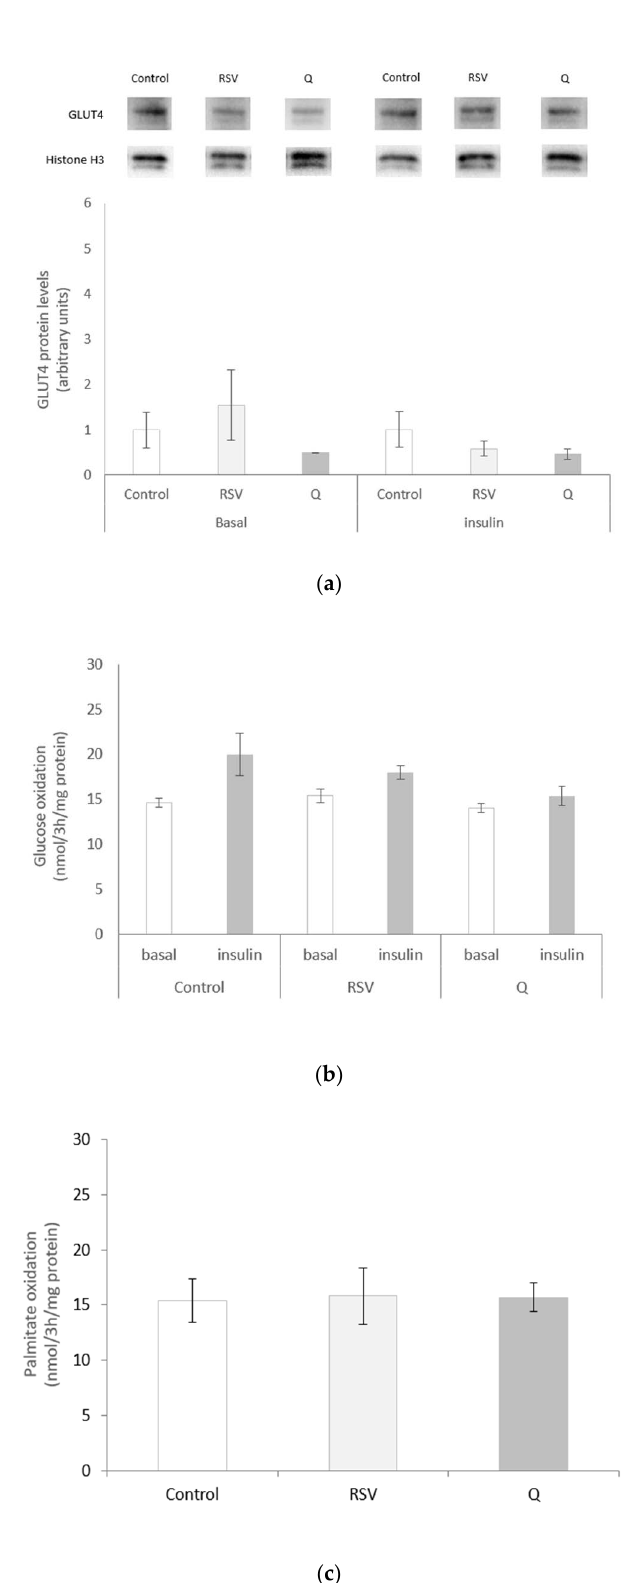
Figure 2. GLUT4 protein expression ( a ), glucose oxidation ( b ) and palmitate oxidation ( c ) in human myotubes treated with 0.1 μM of resveratrol (RSV) and 10 μM of quercetin (Q) for 24 h. All of the data are presented as the mean ± SEM of six ( a ) or three ( b and c ) biological replicates. Comparisons between each treatment group and the control group were analysed by Student’s (cid:1872) -test.